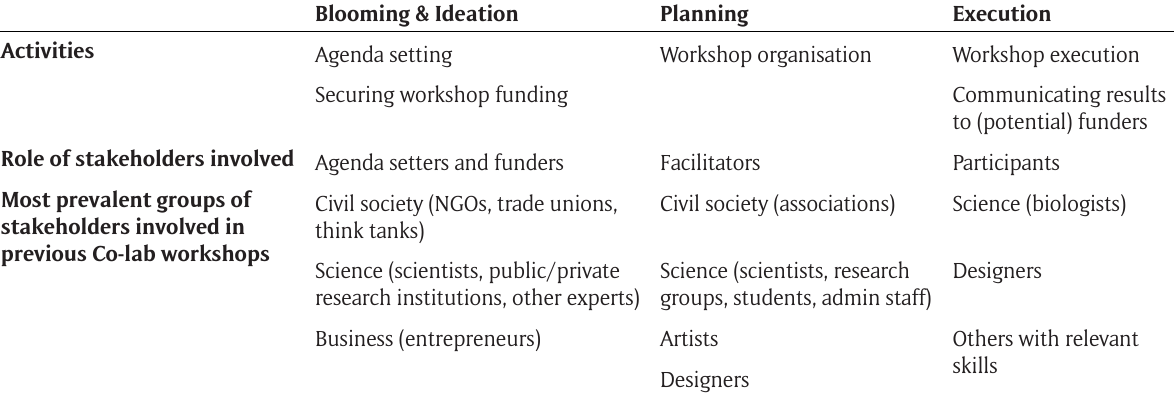
Table 1: Co-lab workshop phases and stakeholders